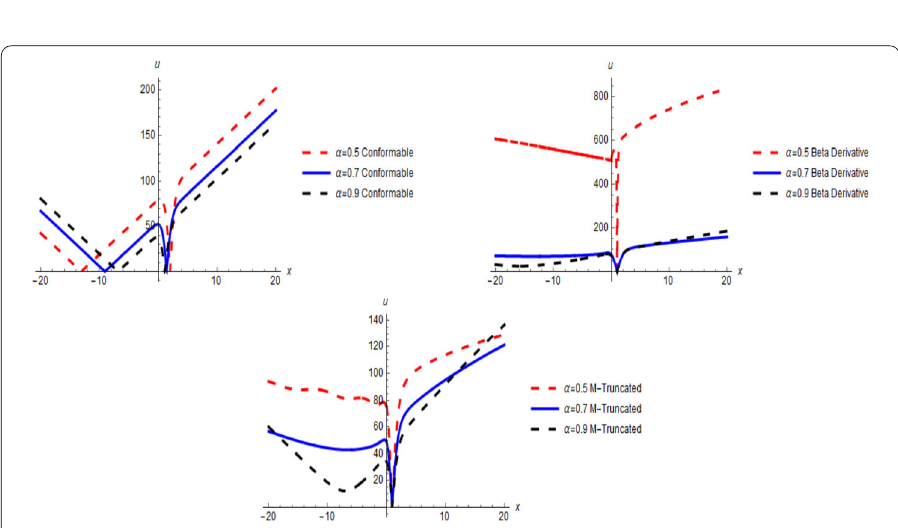
Figure 4 2D-plot of u 1 for different derivatives at t = 1 for different values of α